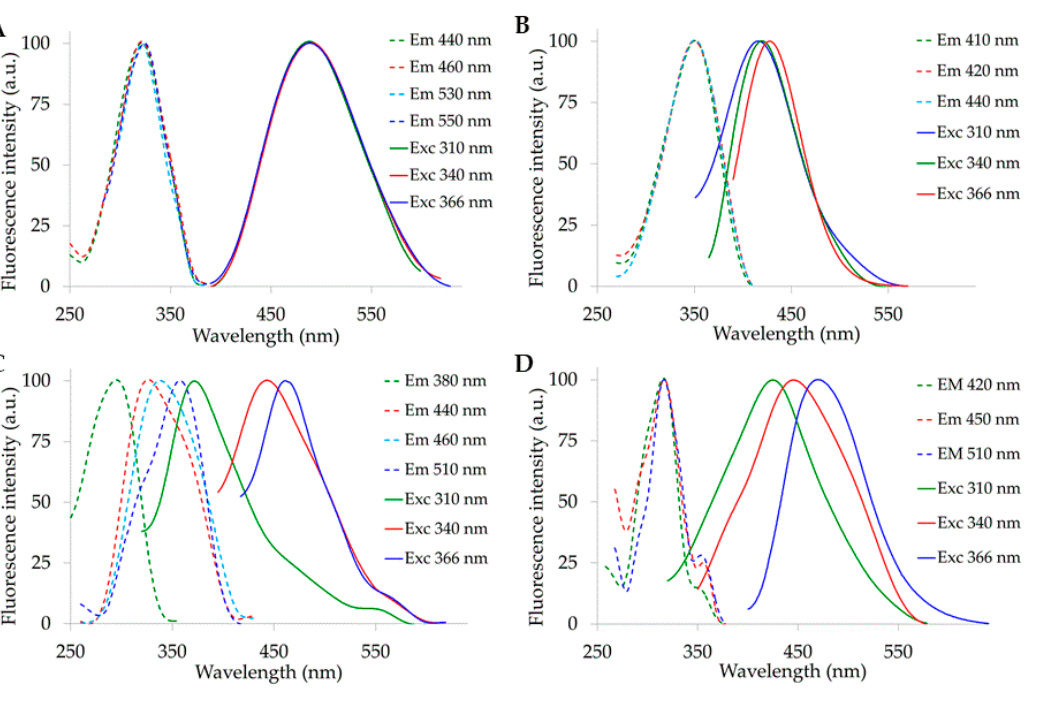
Figure 1. Fluorescence excitation and emission spectra of pure compounds in ethanol solution (100%). ( A ) retinol 1 × 10 − 6 M; ( B ) oleic acid 1 × 10 − 1 M; ( C ) linoleic acid 1 × 10 − 2 M; ( D ) arachidonic acid 1 × 10 − 3 M. Spectra are normalized to the maximum peak value. Excitation and reading emission wavelengths are indicated by colors, on the right.